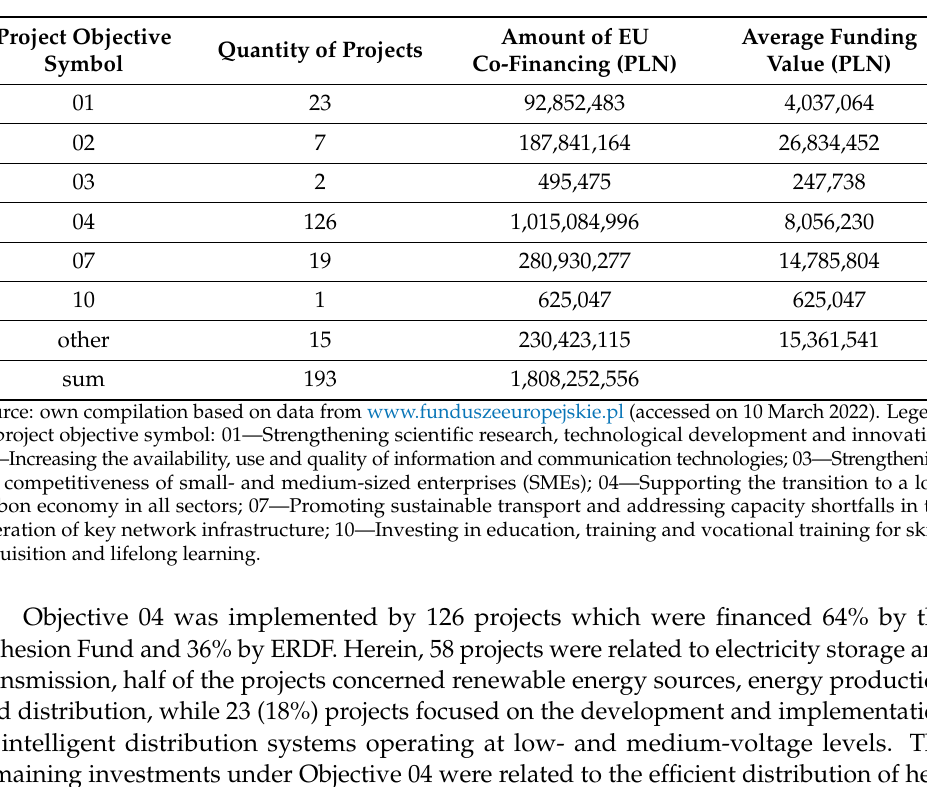
Table 5. Average value of EU funding by project